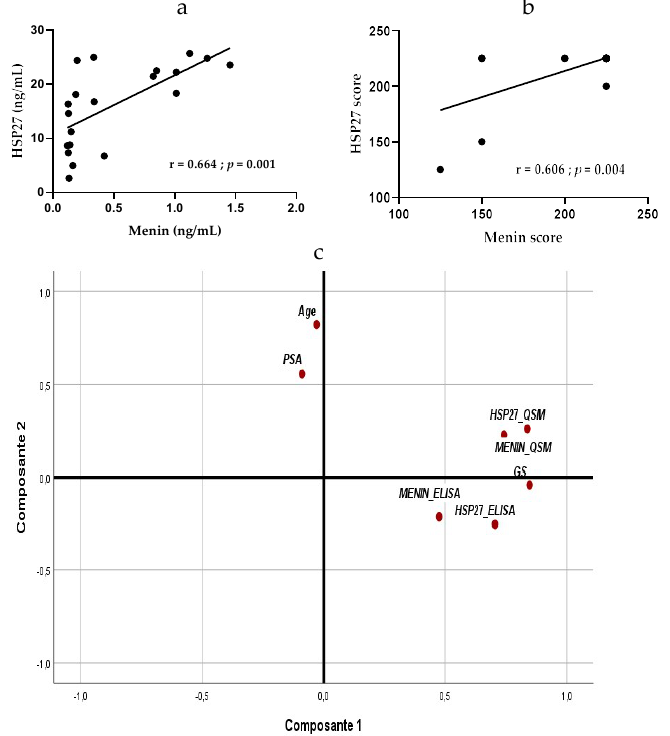
Figure 4. ( a ) Correlation between HSP27 and Menin serum expression in PCa aggressive patients; ( b ) Correlation between HSP27 and Menin tissue expression in PCa aggressive patients; ( c ) PCA of biological parameters (HSP27_QSM, MENIN_QSM: expression of HSP27 and Menin in tissue; HSP27_ELISA, MENIN_ELISA: expression of HSP27 and Menin in